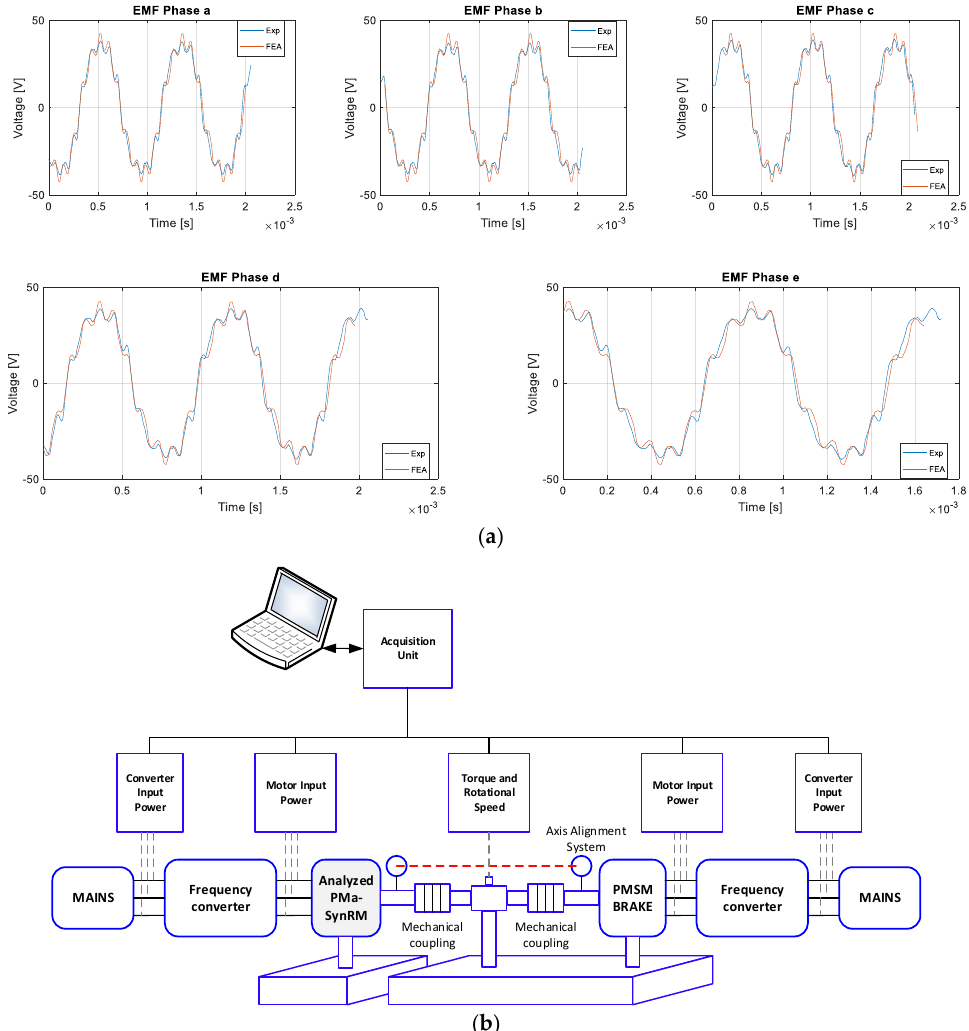
Figure 4. ( a ) Measured and experimental electromotive force (EMF) of the fPMa-SynRM operating at a constant speed of 2000 rev/min under healthy conditions. ( b ) Schematics of the test bench.